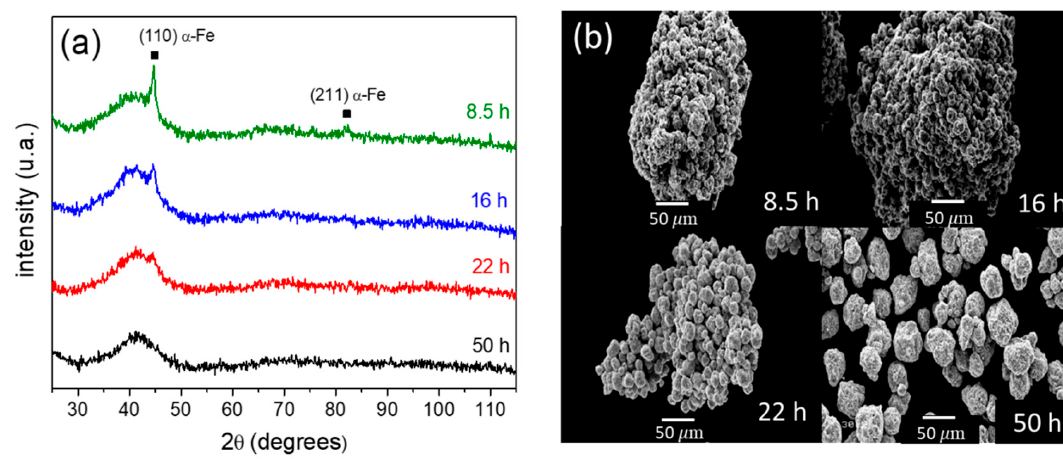
Figure 1. ( a ) XRD patterns and ( b ) scanning electron microscopy images in secondary electron modes after selected milling after selected milling times.